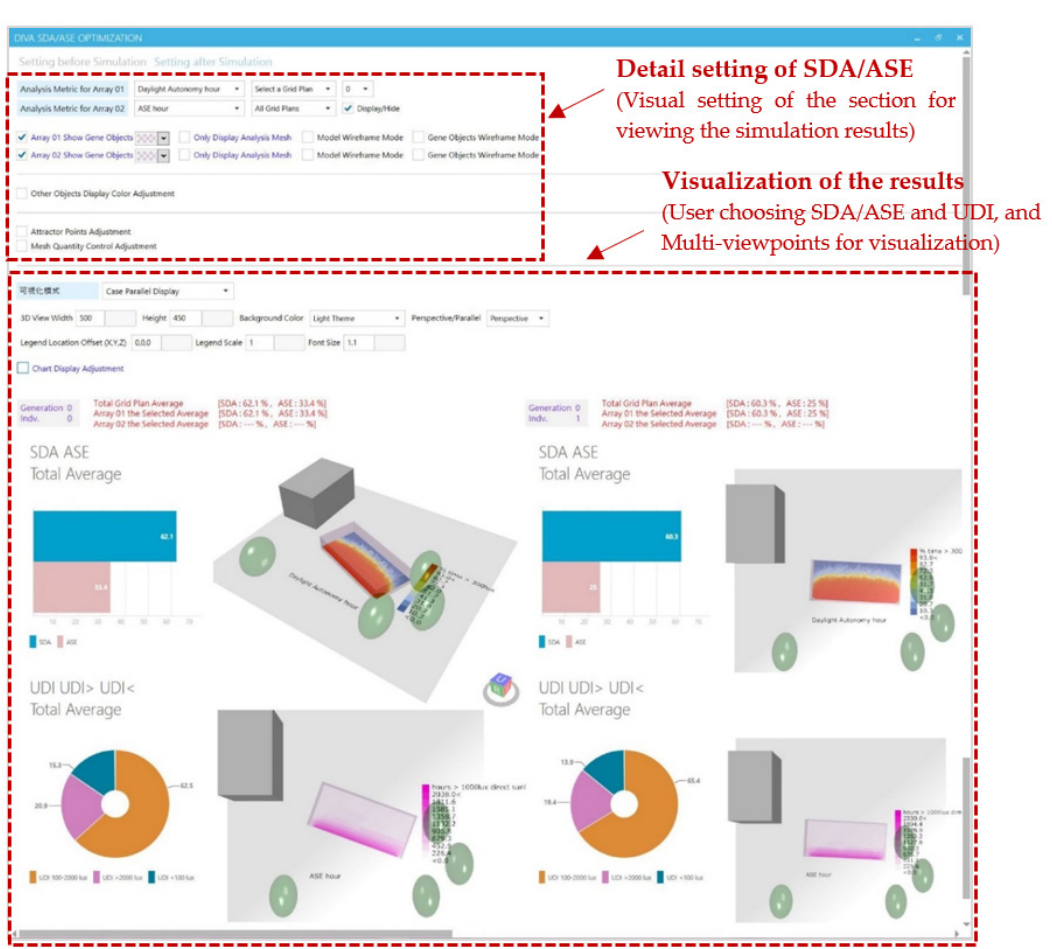
Figure 3. Visualization setting UI for daylight.